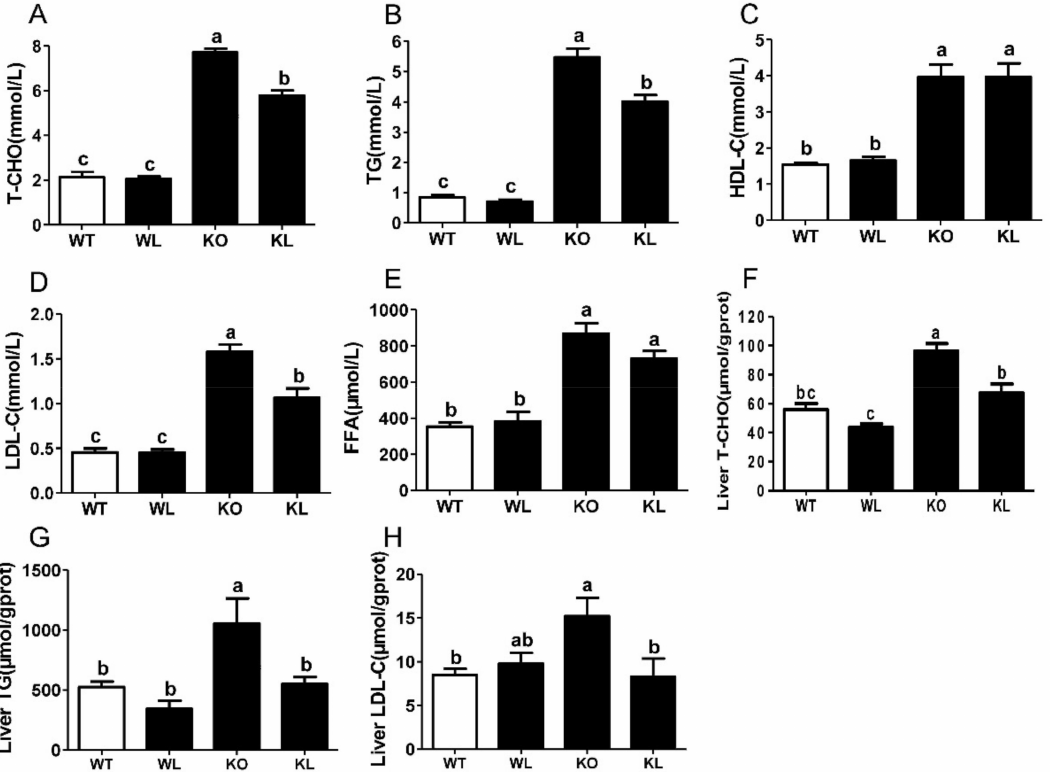
Figure 2. Biochemical indexes of serum and liver in each group of rats. ( A ) Serum total cholesterol; ( B ) serum triglyceride; ( C ) serum high-density lipoprotein cholesterol; ( D ) serum low-density lipopro- tein cholesterol; ( E ) serum free fatty acids; ( F ) liver total cholesterol; ( G ) liver triglyceride; ( H ) liver low-density lipoprotein cholesterol; Values are means ± SEM (n = 4–6). Columns with different letters are significantly different ( p <